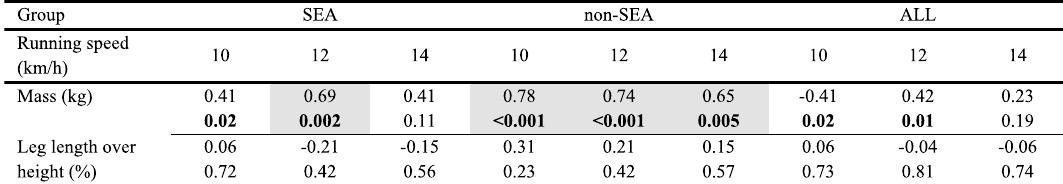
Table 5. Pearson correlation coefficients between running economy and anthropometric characteristics (mass and ratio of leg length over height), together with their corresponding p -values underneath for South East Asian (SEA), non-South East Asian (non-SEA), as well as all runners pooled together (ALL). Note. Only the relationships between running economy and mass and ratio of leg length over height were considered because mass was highly and significantly correlated to height, leg length, and body mass index. Statistical significances ( p ≤ 0.05) gray shaded boxes denote correlation coefficients above an absolute value of 0.5